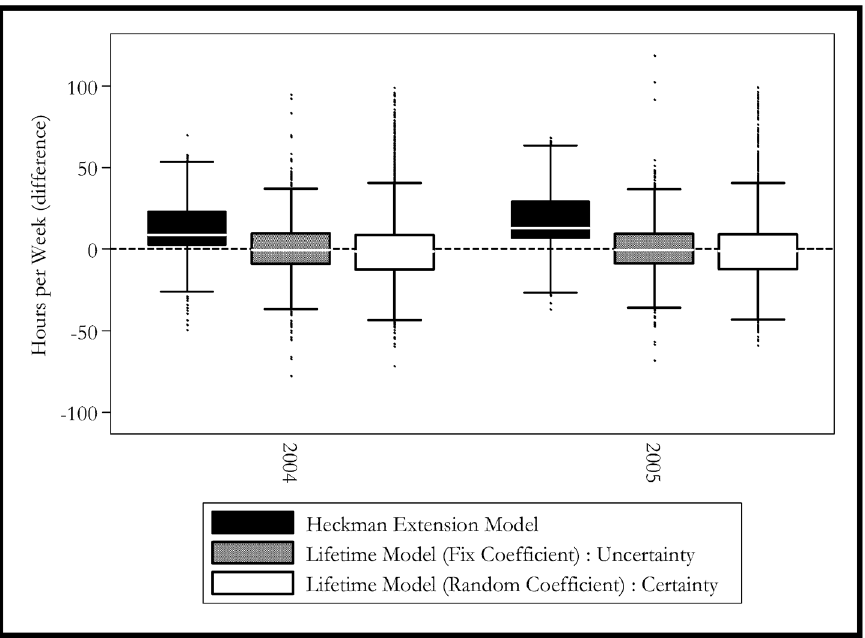
Figure 4. Simulated Hours Distributions by Year. Black Box: Heckman Selection Model. Grey Box: Lifetime Model (Random Coefficient): Certainty. White Box: Lifetime Model (Fix Coefficient): Uncertainty.